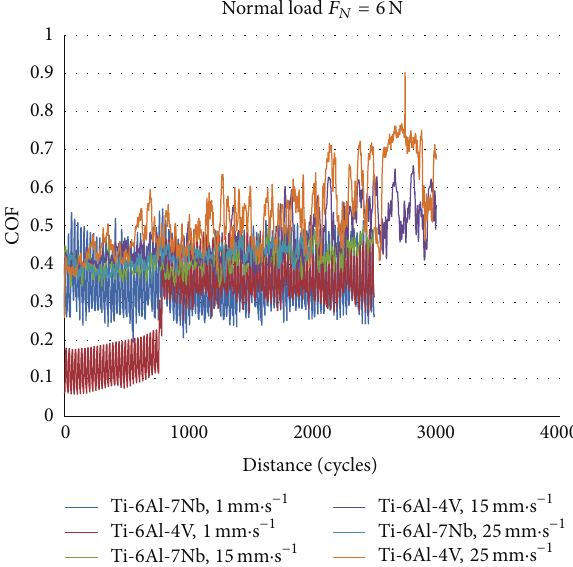
Figure 15: Friction coefficient of titanium alloys versus sliding distance under different sliding speeds at 6 N.